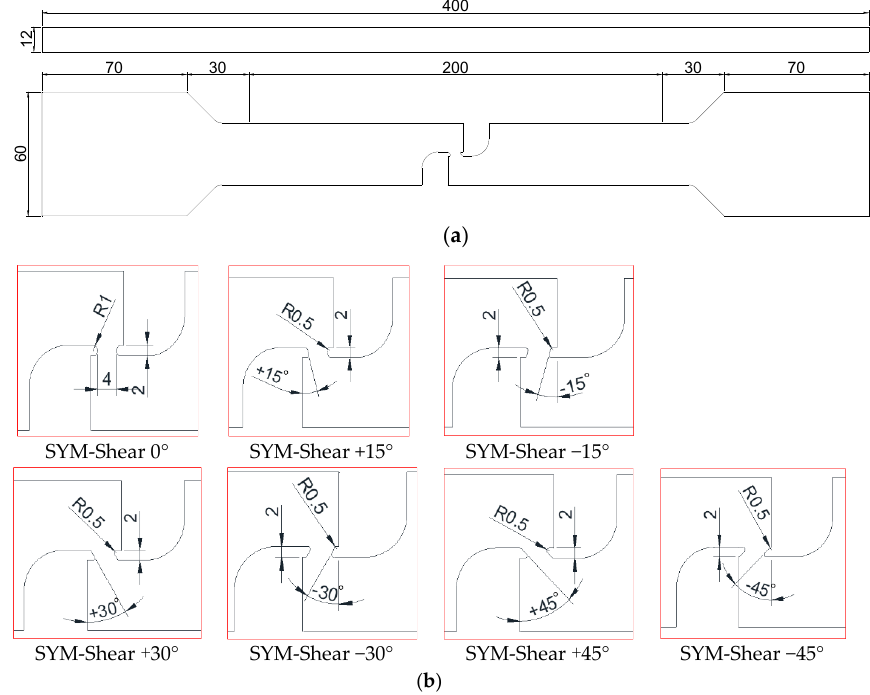
Figure 4. Configuration and dimensions of USYM-Shear specimens: ( a ) Dimensions of the specimen; ( b ) Detailed dimensions of the notch. (unit: